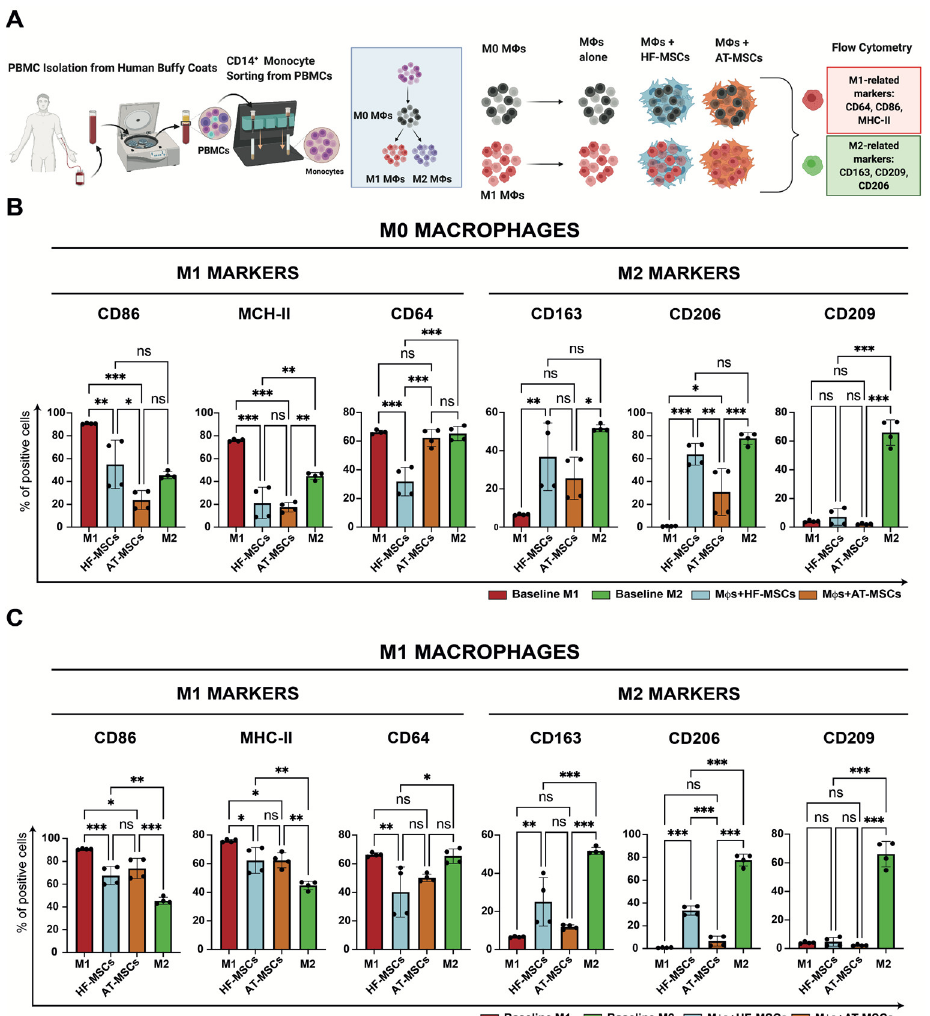
Figure 7. Effect of MSCs on the modulation of macrophage phenotype. ( A ) Schematic of the study. ( B , C ) % of cells positive for either M1-related or M2-related marker expression when M0 macrophages ( B ) or M1 macrophages ( C ) were cocultured with MSCs. Each datapoint represents the mean ± SD of four wells. Statistical significance: *** p < 0.001 and ** p < 0.01 and * p < 0.05 when compared with macrophages without MSCs; ns: not significant differences, p > 0.05. PBMCs, peripheral blood mononuclear cells. Mφ, macrophages. HF-MSCs, hair follicle-derived MSCs. AT-MSCs, adipose tissue-derived MSCs.